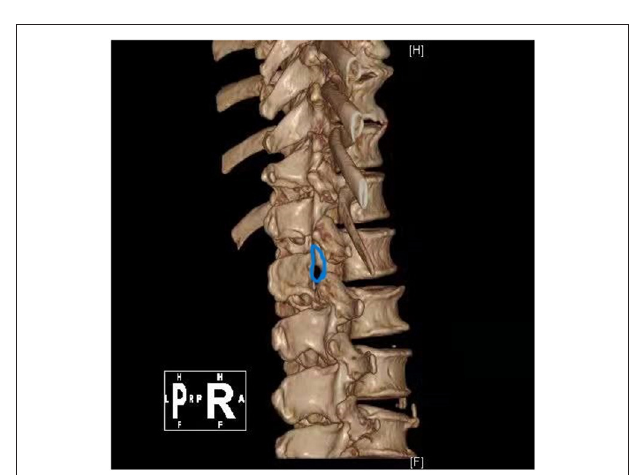
FIGURE 6 | Postoperative 3D CT reconstruction of the case